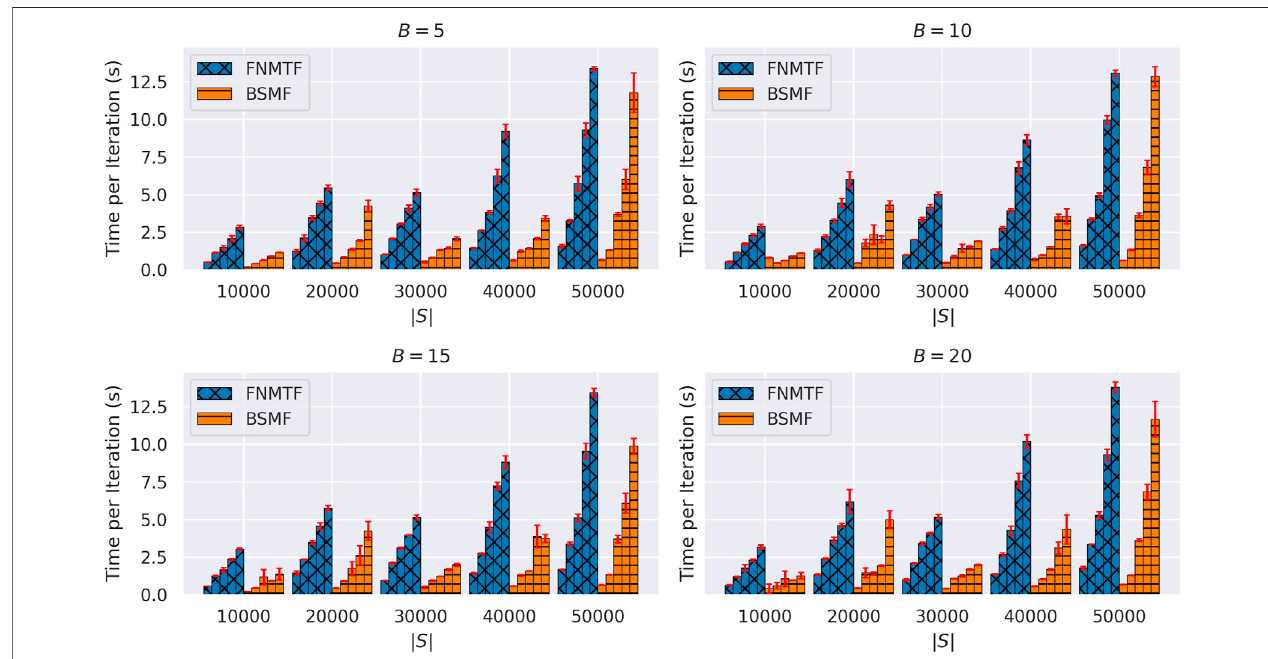
FIGURE 3 | Running time under different con fi gurations of dimensions of X and B . For each method, under the same | S |, | C | takes 10000, 20000, 30000, 40000, 50000 respectively. Red bar indicates standard deviation on time measurements.